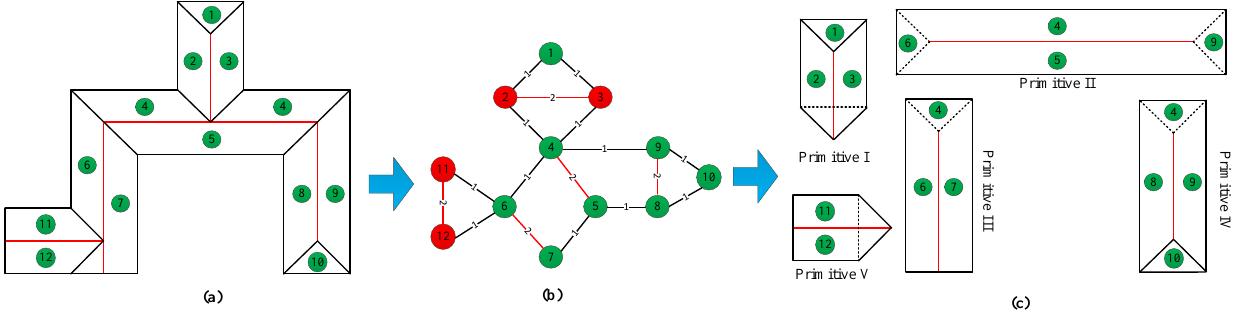
Figure 2. Illustration of the proposed semantic decomposition method. ( a ) A compound building and its segmented planar patches (numbered in green circle); ( b ) attributed graph of the segmented planar patches; and ( c ) results of the proposed semantic